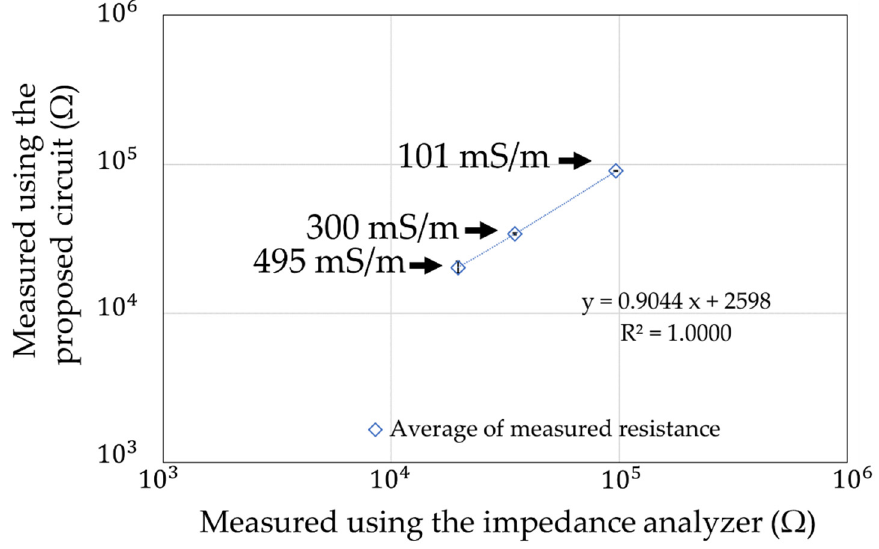
Figure 25. Measurement results of the ion concentration in soil.